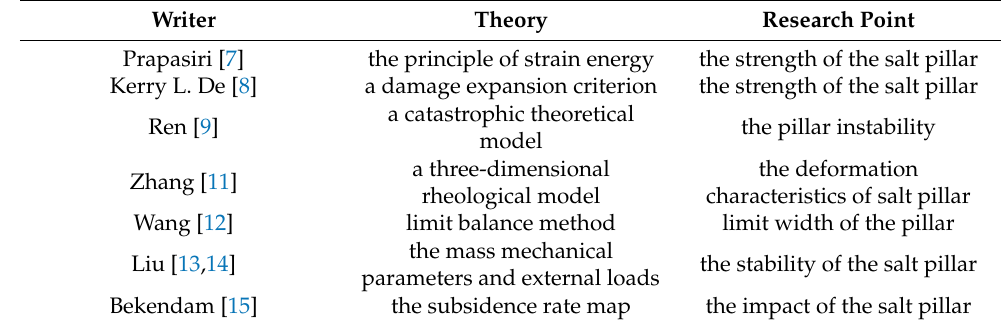
Table 1. Basic theory of salt pillar